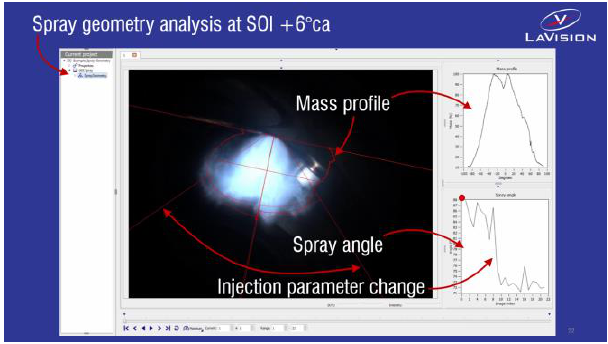
Fig. 10. Computer processing of an image to extract quantitative data on the physicochemical processes captured in the photograph [41]